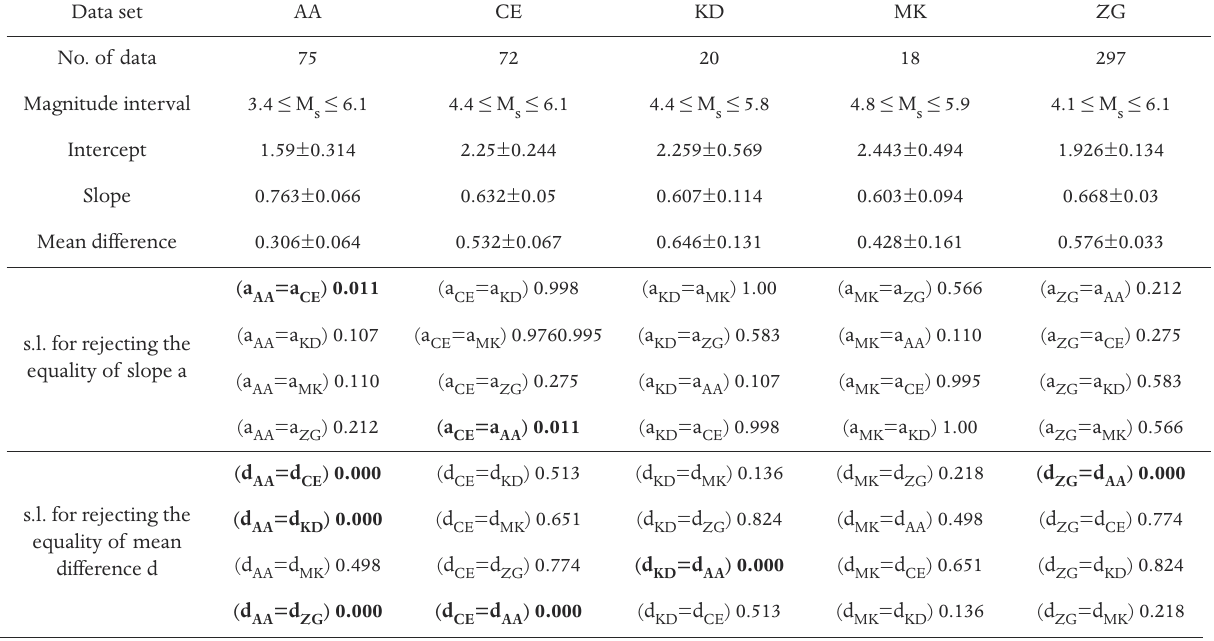
Table 2. As Table 1 for the M